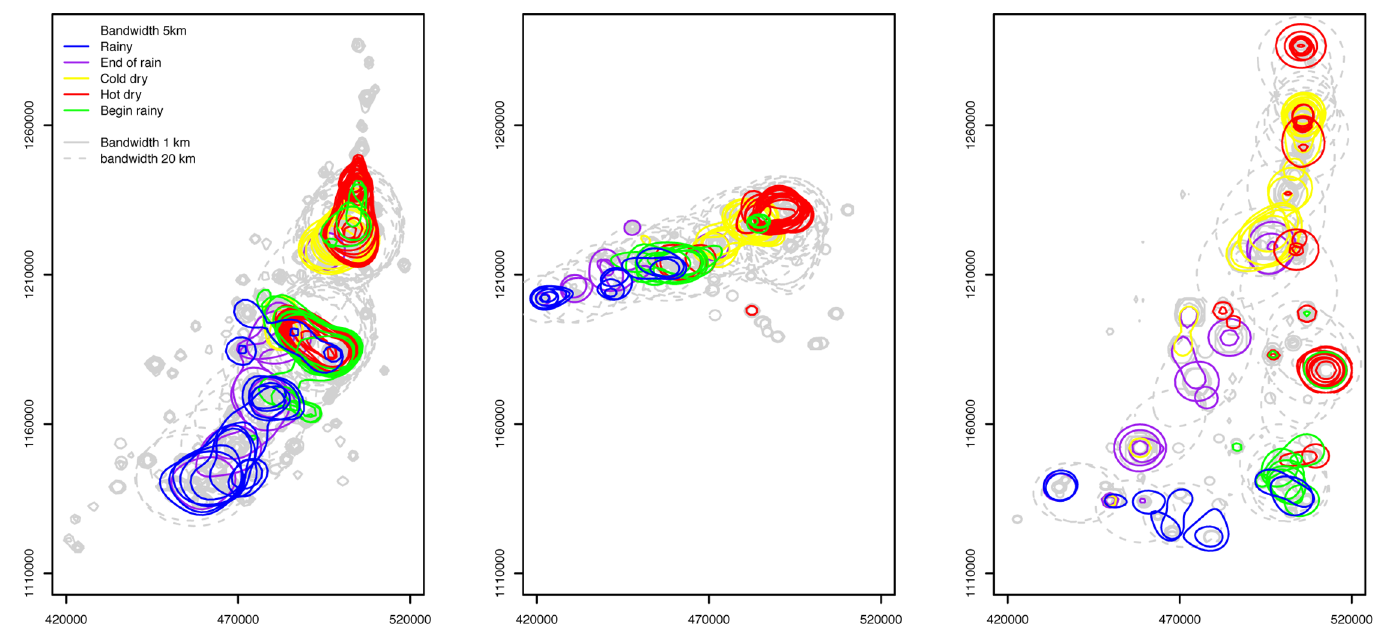
Fig 9. Results from the KRN model. Each contour encloses an area where F ( x t = x ) (cid:1) 95%. Each map shows the result after overlaying the contours of every 5 days throughout the year. Groups 1, 2, and 3 are represented in the figures from left to the right. Each map shows the results from three bandwidths: 1 km (light grey solid lines), 5 km (colored solid lines), and 20 km (dashed light grey